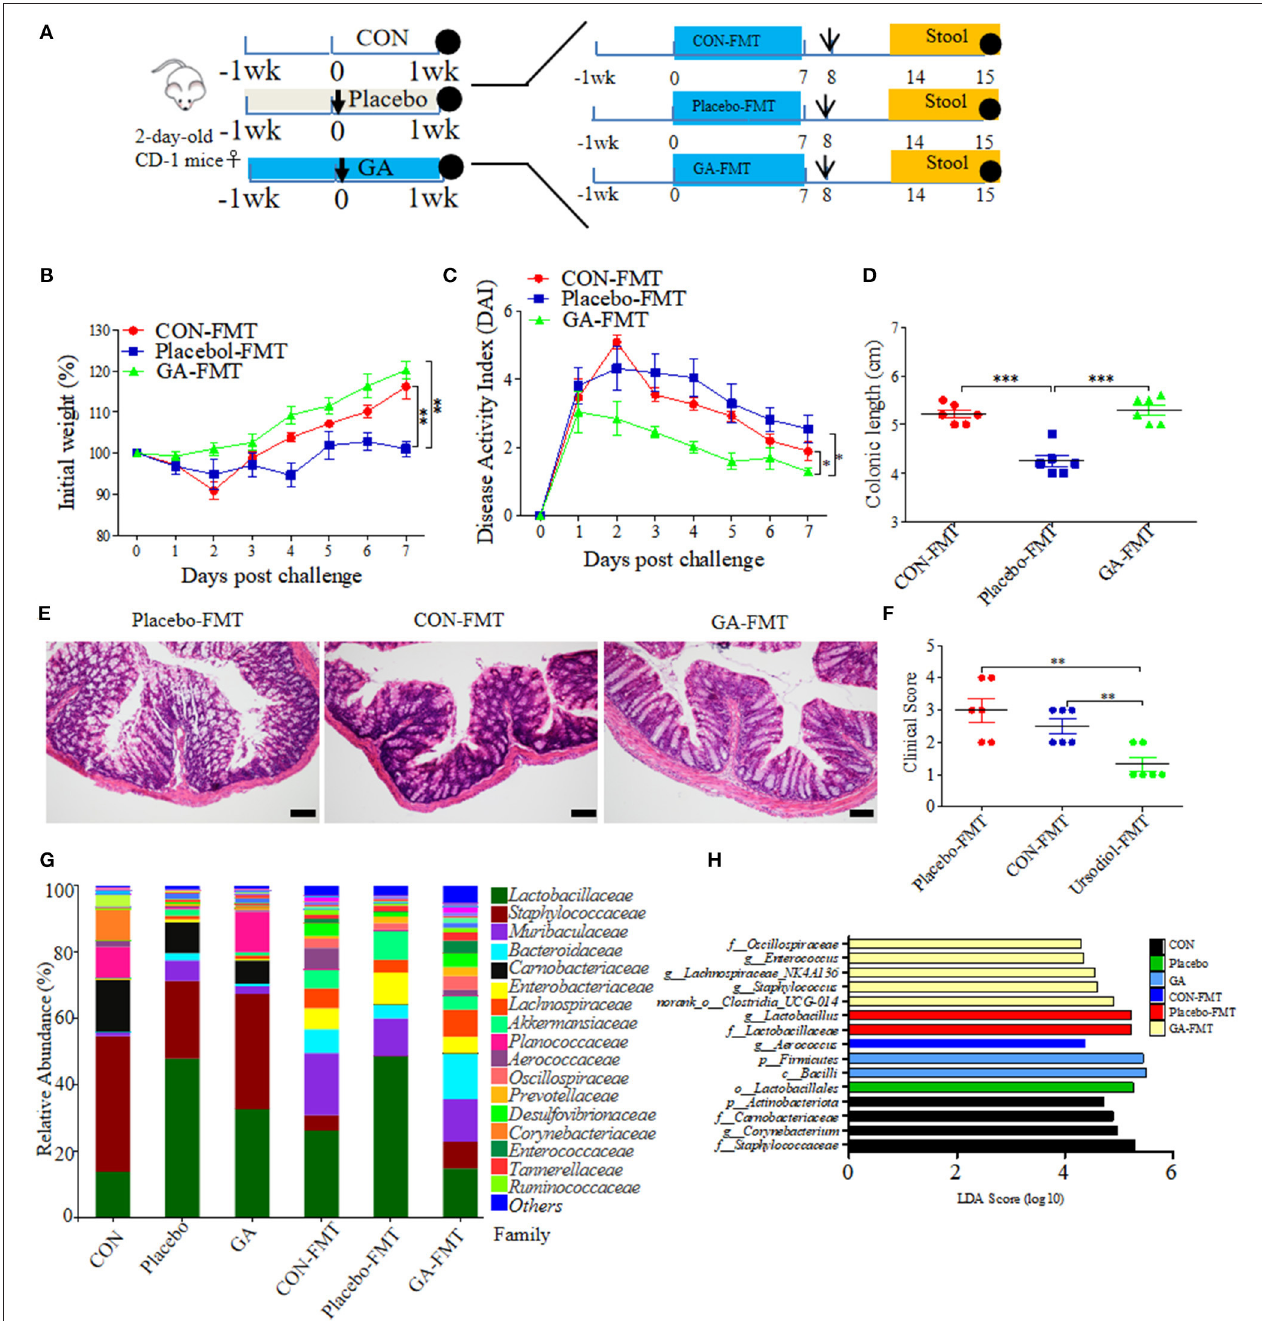
FIGURE 8 | Fecal microbiota transplantation (FMT) of GA-treated mice ameliorated colitis induced by ESBL-EAEC infection. (A) Diagram illustrating the neonatal mice model employed in this trial. GA-FMT, CON-FMT, and Placebo-FMT were indicated. The arrow represented infection time point and the circle represented harvest time. Daily body weight changes post infection (B) and kinetics of DAI scores in this trial (C) . Data were presented as means ± SEM ( n = 6 per group). Statistical significance was determined using two-way ANOVA. ** p ≤ 0.01, *** p ≤ 0.001 relative to Placebo-FMT group. (D) Colonic lengths of each group. H&E-stained colon tissues (E) and histological scores of colons (F) . (G) Fecal bacterial family’s relative abundance represented by 99.5% of the community. (H) Analysis of differences in enriched microbiota taxa shown by linear discriminant analysis (LDA) coupled with effect size measurements (LEfSe) upon FMT.